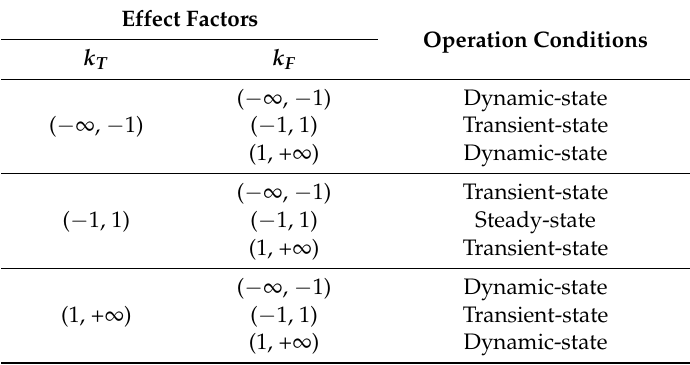
Table 3. Effect factors for different operation conditions.